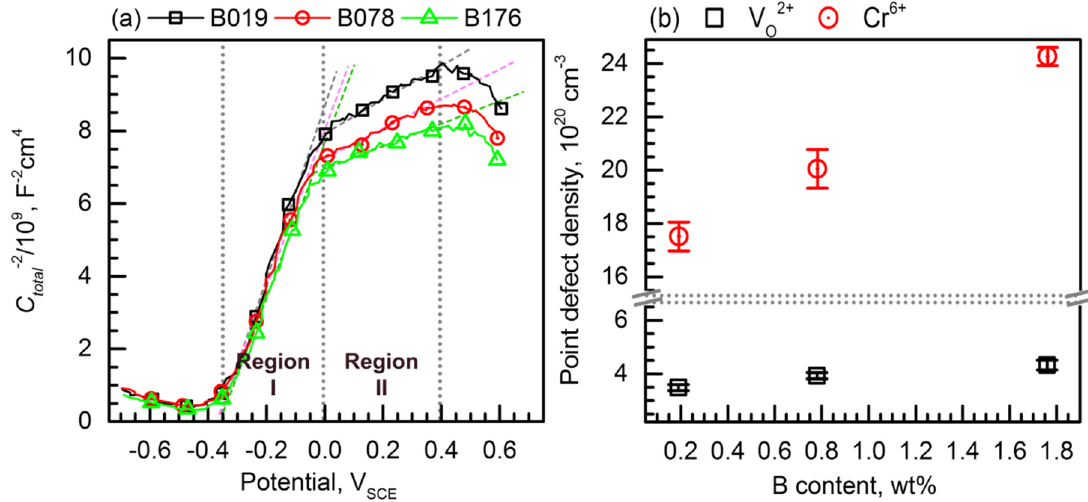
Figure 10. ( a ) Mott–Schottky plots for the passive films formed on the borated stainless steels (BSSs). The passive films were formed in a borate–phosphate–citric buffer solution (pH 8.5) by applying constant anodic potential of 0.6 V SCE for 1 h, and the capacitance of the passivated layer was measured at a frequency of 1000 Hz with an imposing sinusoidal voltage perturbation of ±0.01 V (peak ‐ to ‐ peak); ( b ) Variations of the densities of the point defects (V O2+ and Cr 6+ ) as a function of